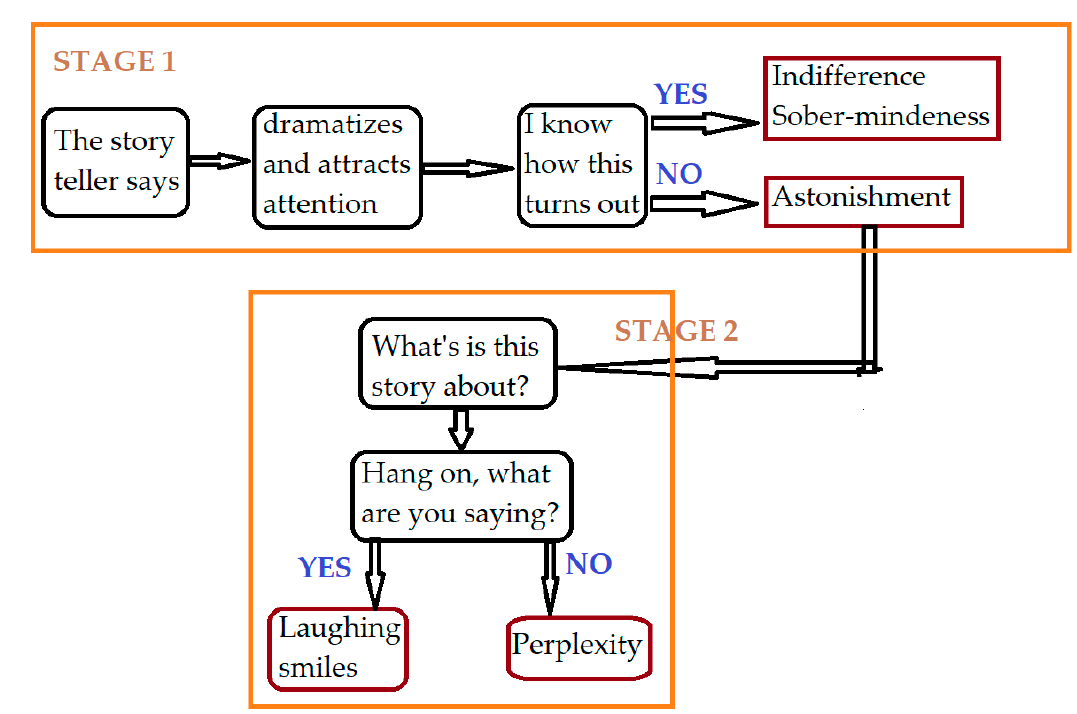
Figure 1. Suls’ incongruity resolution model, adapted from Jerry M. Suls (1972, 1983).